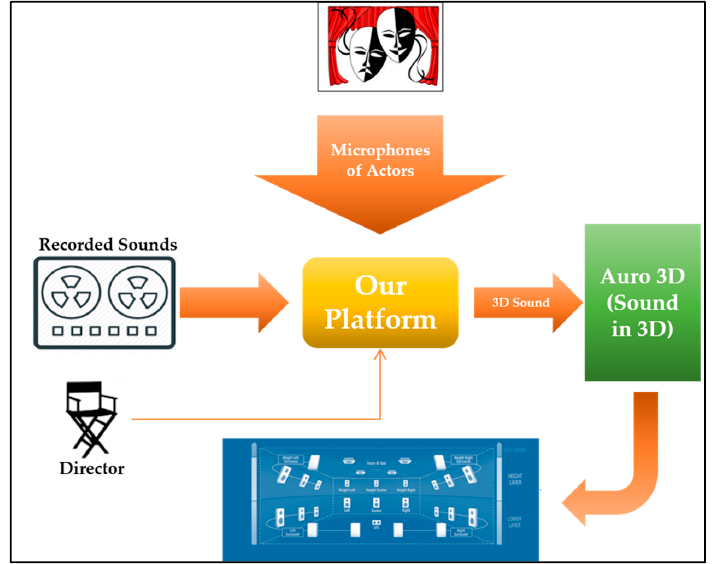
Figure 6. Use case scenario 1 — spatial sound using speakers based on the Auro3D protocol.